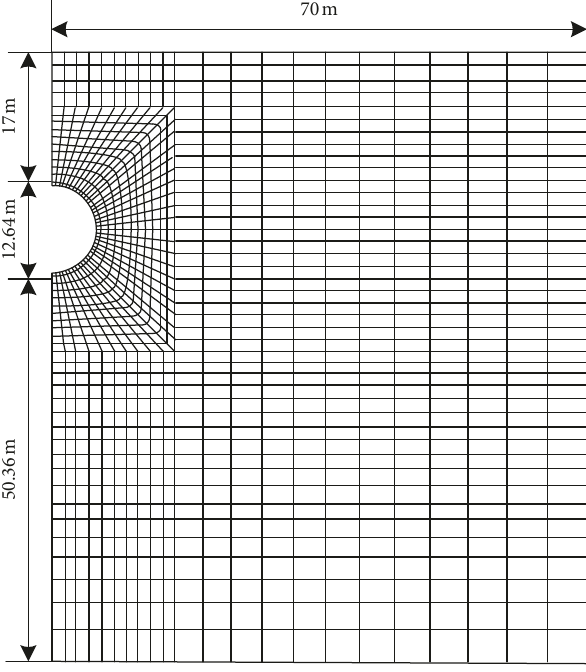
Figure 7: The numerical model of the Qinghuayuan tunnel.